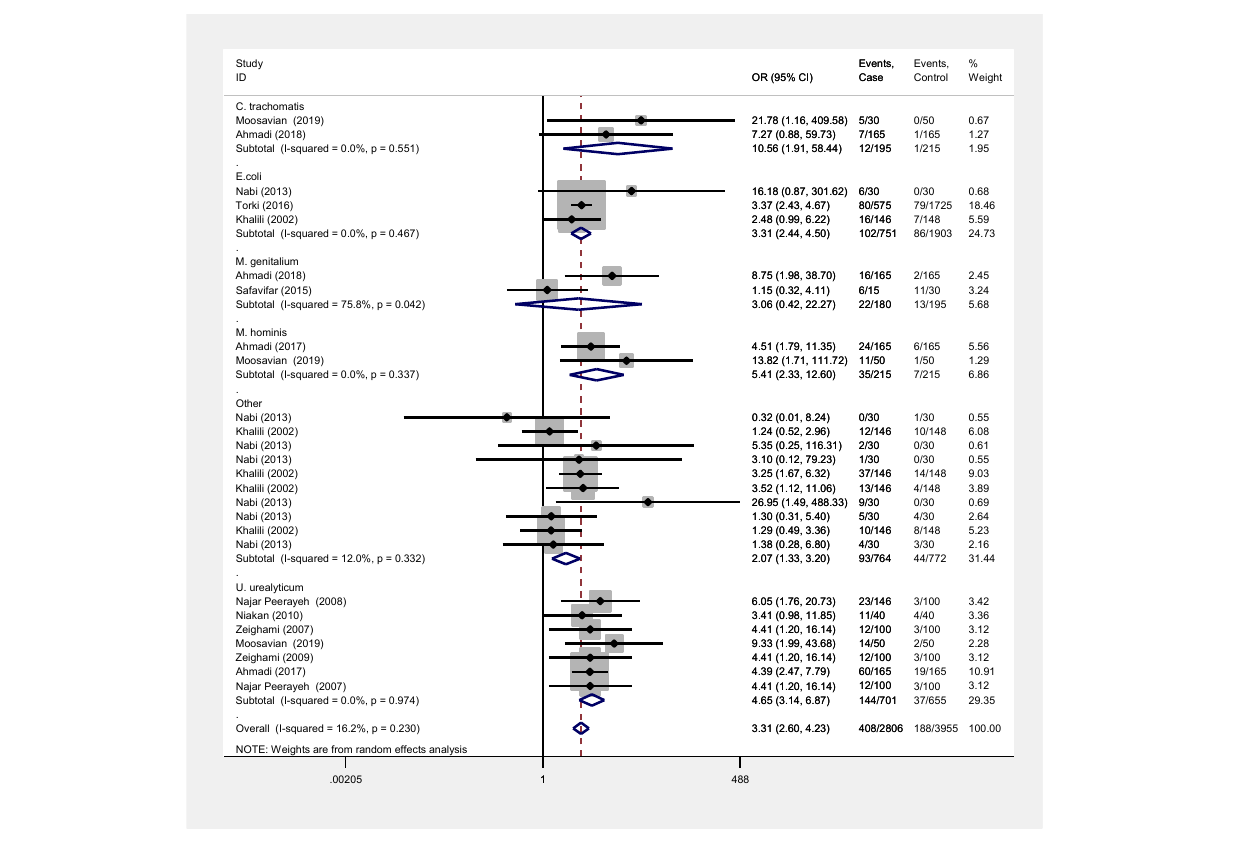
according to Higgins and Thompson (15), an I 2 value of less than 25% indicates low heterogeneity, 25–75% indicates moderate heterogeneity, and over 75% indicates high heterogeneity.